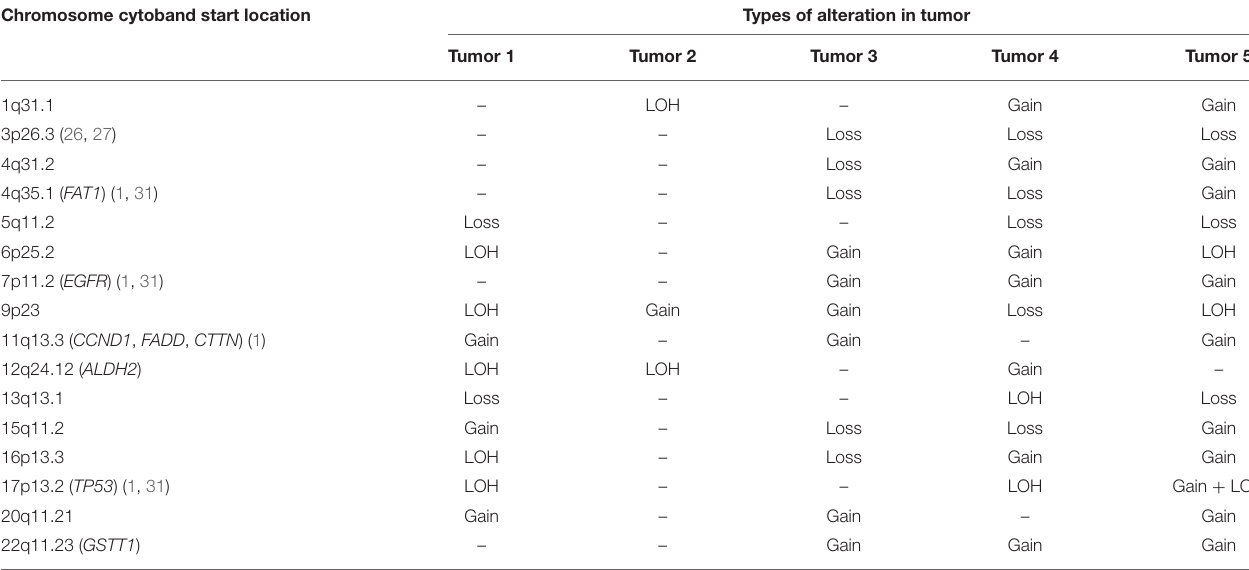
TABLE 1 | Genetic alterations on the same chromosomal location common to at least three tumors. Chromosome cytoband start location